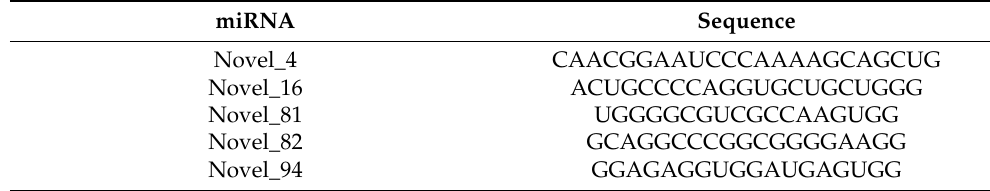
Table 1. The sequence of novel